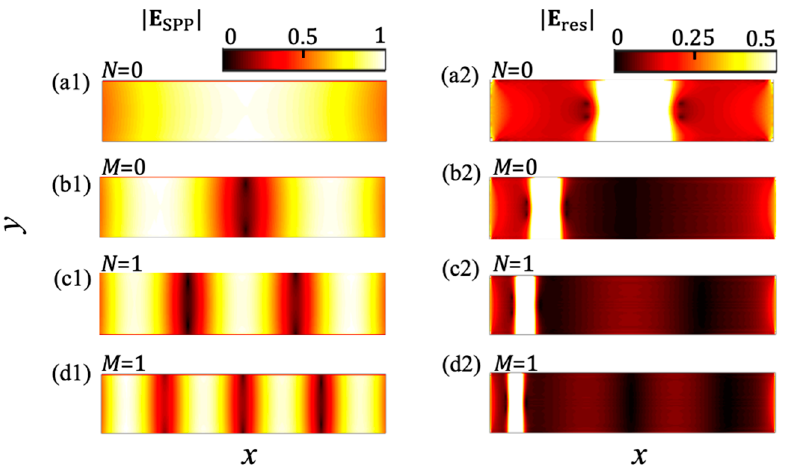
Figure 3. SPP field | E SPP | (left column) and the residual field | E res | (right column). ( a – d ) are obtained at the first four resonance peaks in Figure 2(b) ( L = 124, 314, 514, 704 nm , respectively) under the point-source excitation. The electric field amplitude | E | = (| E x | 2 +| E y | 2 +| E z | 2 ) 1/2 on the z = h /2 plane in the rectangular aperture (width D = 30 nm ) is shown. For a direct comparison, all the SPP fields | E SPP | are normalized to have a maximum value of 1.